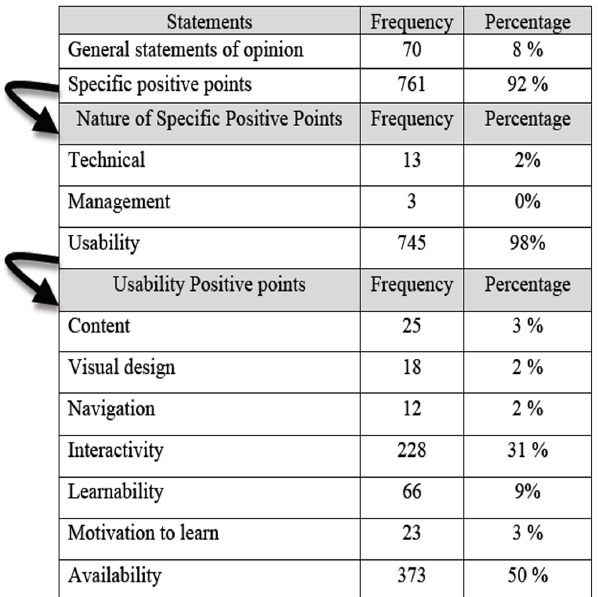
Table 2. Classification of positive